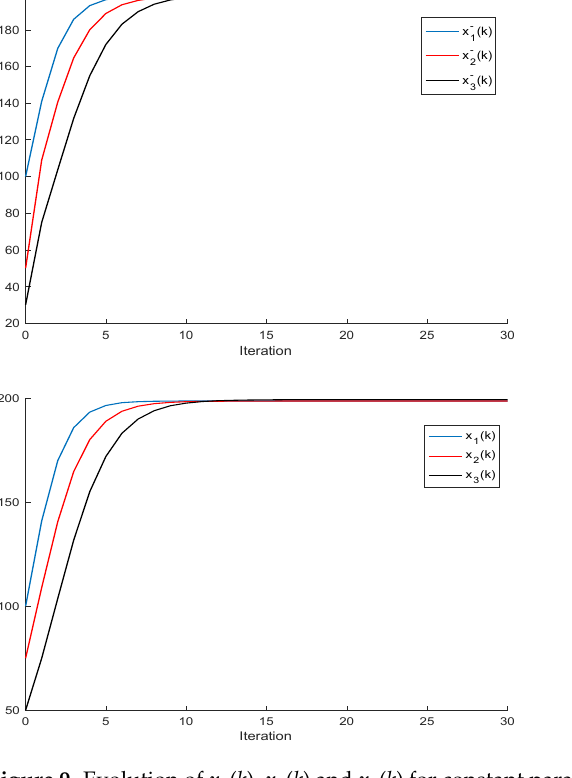
Figure 9. Evolution of x 1 ( k ) , x 2 ( k ) and x 3 ( k ) for constant parameters in Example 6 when no harvesting quota nor external consumption are included so that left-hand side values and right-hand side values are coincident. The coupling matrix C has small non-diagonal entries and the three species converge to the same equilibrium point.